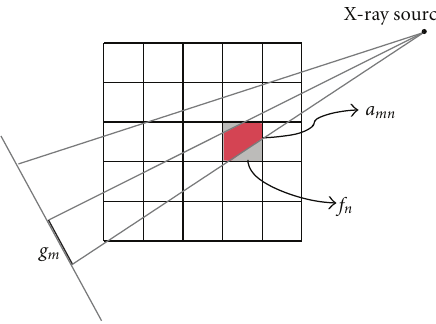
Figure 1: Projection model of a discrete image in fan-beam